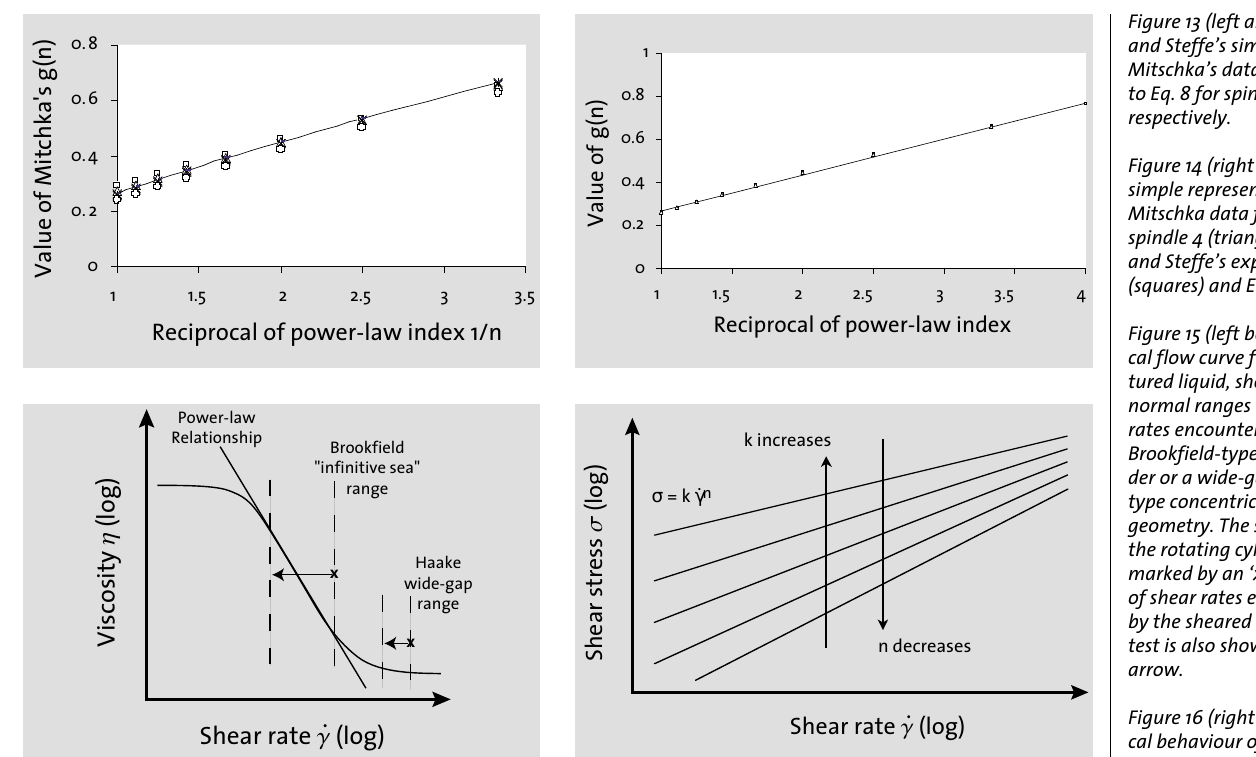
Figure 13 (left above): Briggs and Steffe’s simplification of Mitschka’s data according to Eq. 8 for spindles 2 – 6 respectively. Figure 14 (right above): A simple representation of the Mitschka data for g(n) for spindle 4 (triangles); Briggs and Steffe’s expression (squares) and Eq. 9. Figure 15 (left below): Typi- cal flow curve for a struc- tured liquid, showing the normal ranges of shear rates encountered using a Brookfield-type dip-in cylin- der or a wide-gap Haake- type concentric cylinder geometry. The shear rate at the rotating cylinder is marked by an ‘x’. The range of shear rates experienced by the sheared liquid under test is also shown as an arrow. Figure 16 (right below): Typi- cal behaviour of a ‘family’ of products - k increases and n decreases, or vice